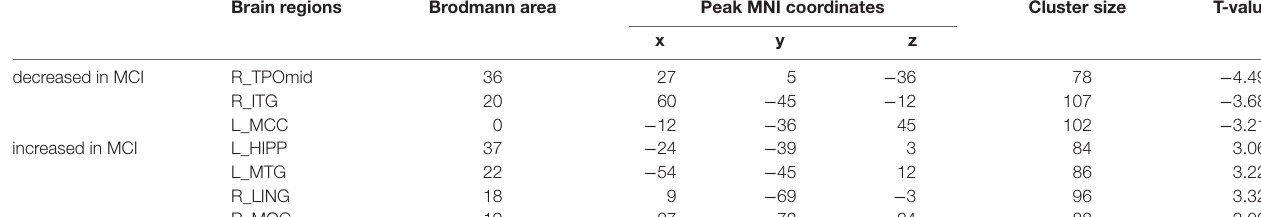
TABLE 3 | Brain regions with different ALFF values between MCI patients and HCs in the resting state. Brain regions